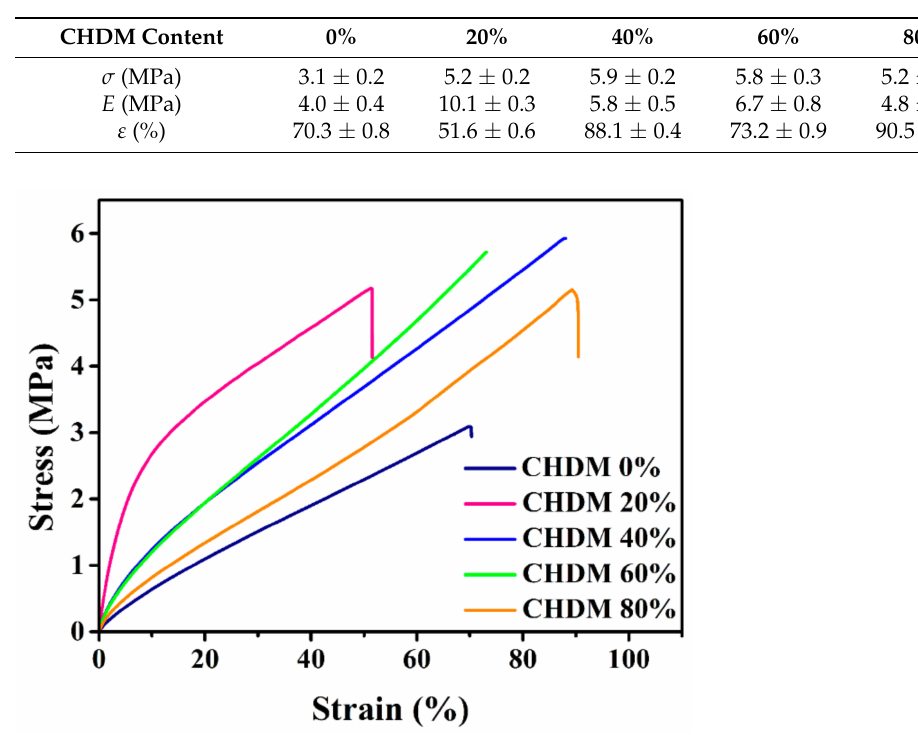
Table 5. Tensile properties of cross-linked films.